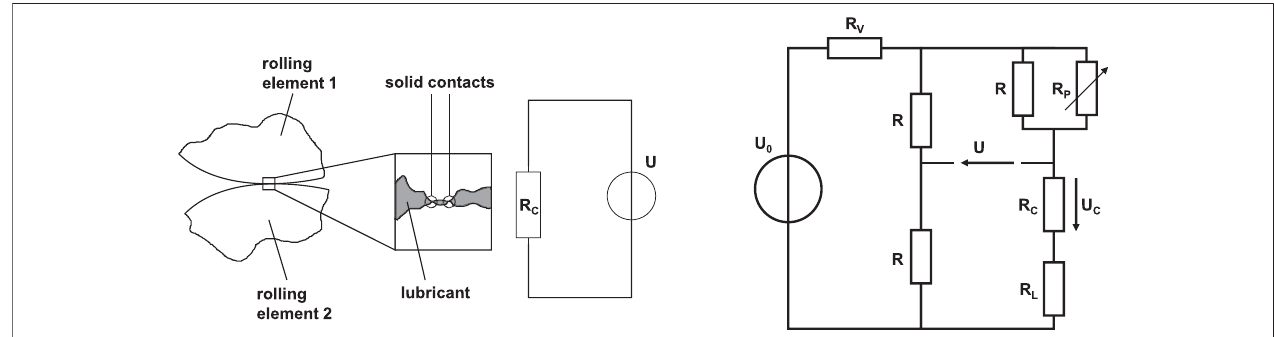
FIGURE 7 | Principle of electrical contact resistance measurement in tribological contact (left) and circuit diagram of measurement setup (right).